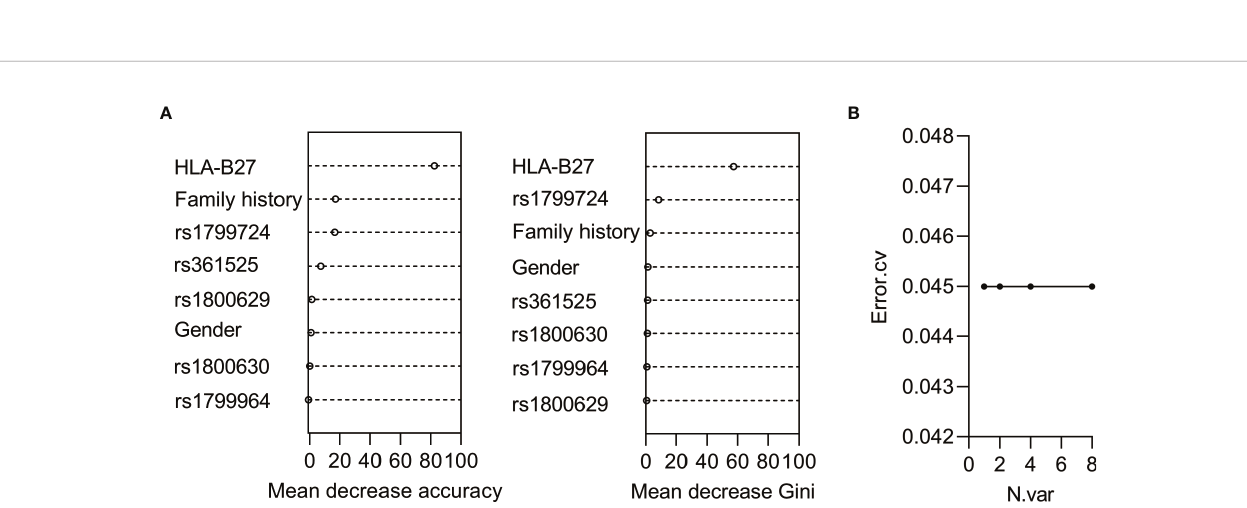
FIGURE 3 | Analysis of the contribution of the variables for AS based on random forest algorithm. (A) The ranking chart of the two accuracy indicators. (B) The line chart of the relationship between numbers of variables and